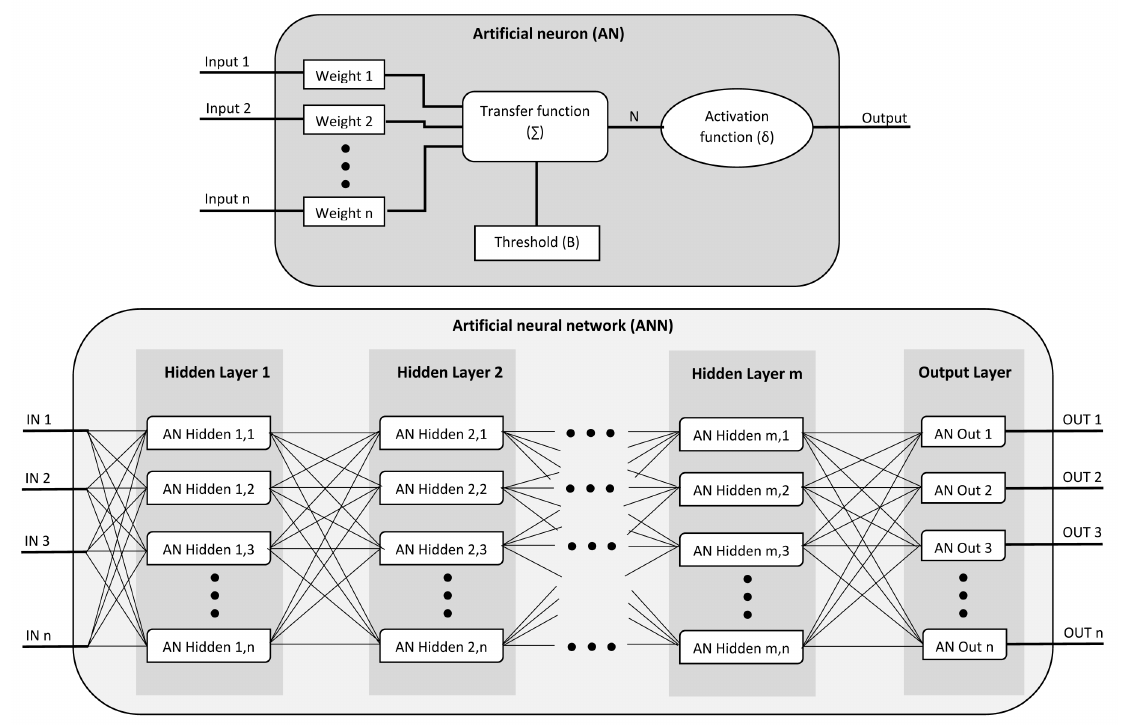
Figure 4. Scheme of Multilayer Perceptron neural